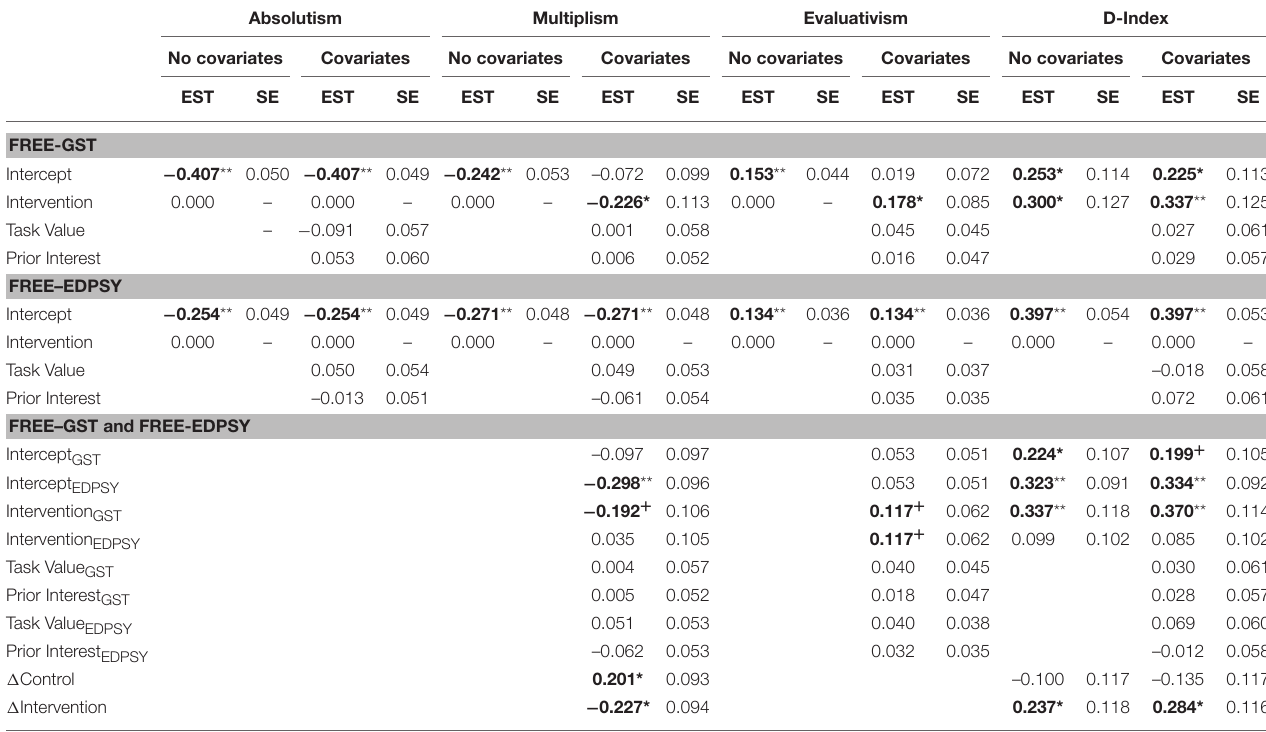
TABLE 6 | Regression coefficients of target models predicting epistemic change in absolutism, multiplism, evaluativism and the D-Index (measured by FREE-GST and FREE-EDPSY).